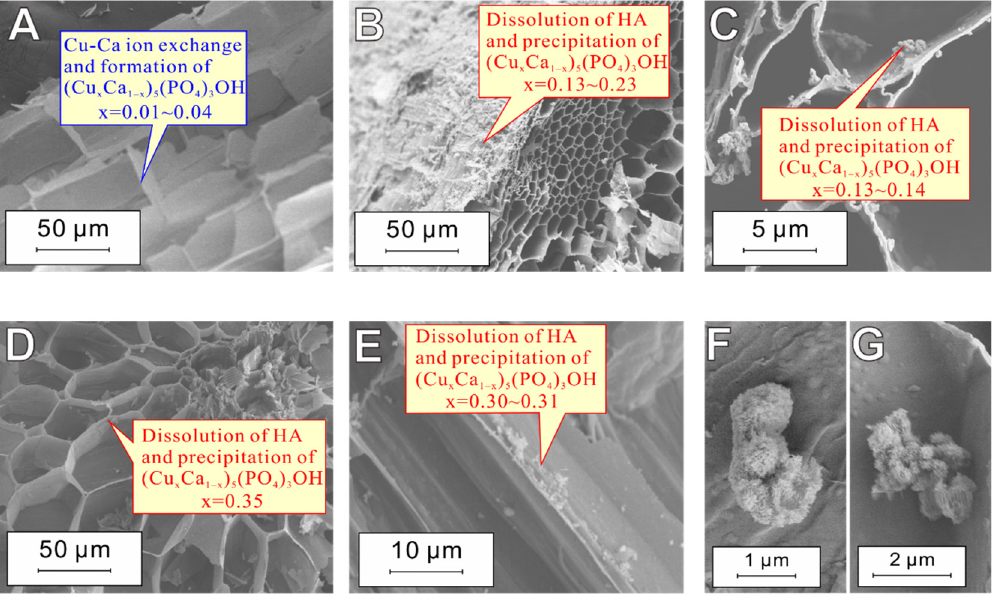
Figure 4. SEM-EDS spectra of the SC–HA/C composite after Cu (II) removal. ( A ) SEM-EDS image of Cu-Ca ion exchange and formation of (Cu x Ca 1 − x ) 5 (PO 4 ) 3 OH, x = 0.01–0.04; ( B ) SEM-EDS image of dissolution of HA and precipitation of (Cu x Ca 1 − x ) 5 (PO 4 ) 3 OH, x = 0.13–0.23; ( C ) SEM-EDS image of dissolution of HA and precipitation of (Cu x Ca 1 − x ) 5 (PO 4 ) 3 OH, x = 0.13–0.14; ( D ) SEM-EDS image of dissolution of HA and precipitation of (Cu x Ca 1 − x ) 5 (PO 4 ) 3 OH, x = 0.35; ( E ) SEM-EDS image of dissolution of HA and precipitation of (Cu x Ca 1 − x ) 5 (PO 4 ) 3 OH, x = 0.30–0.31; ( F ) and ( G ) Needle-like precipitates on the surface of SC–HA/C.